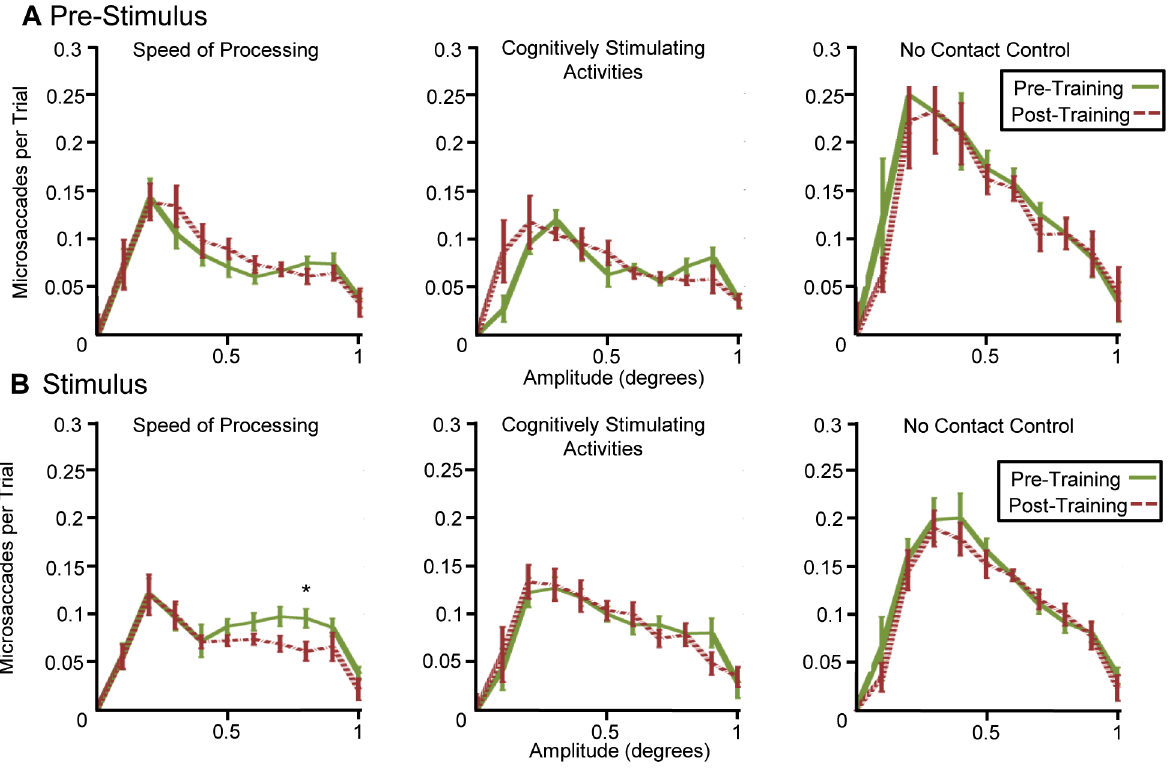
Figure 3. Comparison of Training Groups. Microsaccades were sorted into bins for pre- and post-tests for each group. Within participant standard error of the means are shown and paired t-tests were used to analyze the distribution at each bin. (A) Pre-stimulus data show no significant difference between pre- and post-tests. Data during the stimulus period shows no significant difference in microsaccade amplitude except at 0.8 amplitude in the SOP group (B). This difference was only significant at a =0.05 prior to multiple comparisons correction but was consistent with the microsaccade suppression hypothesis. doi:10.1371/journal.pone.0107808.g003 no statistically significant difference during the stimulus timeframe, failing to disprove the null hypothesis (Figure 4B). Analyses revealed no significant demographic differences between training groups (Table 1) and no significant demographic differences between the high and low risk groups (Table 2) suggesting that our results are unlikely a function of demographics.